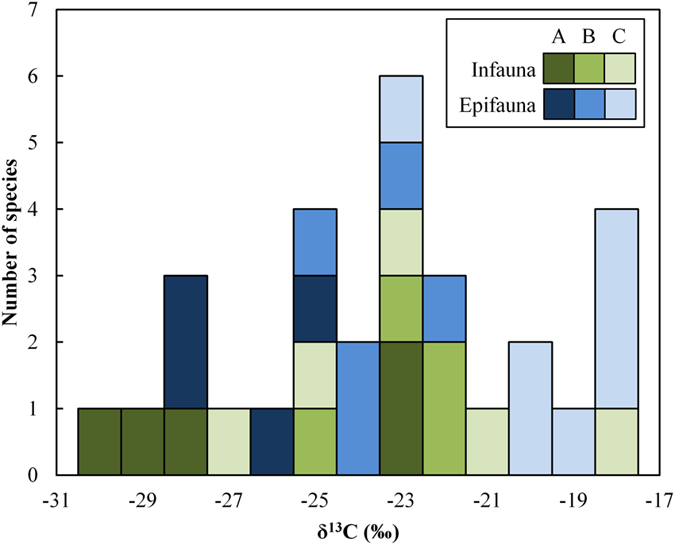
Frequency histogram of the δ13C signatures of all malacostracan and polychaete grazers/collectors (n = 31 samples) within the main pools at Cape Recife (A), Schoenmakerskop (B), and Seaview (C). Organisms are differentiated according to whether they are found directly within the stromatolite material (infauna: green bars) or sampled from within the pool waters (epifauna: blue bars).